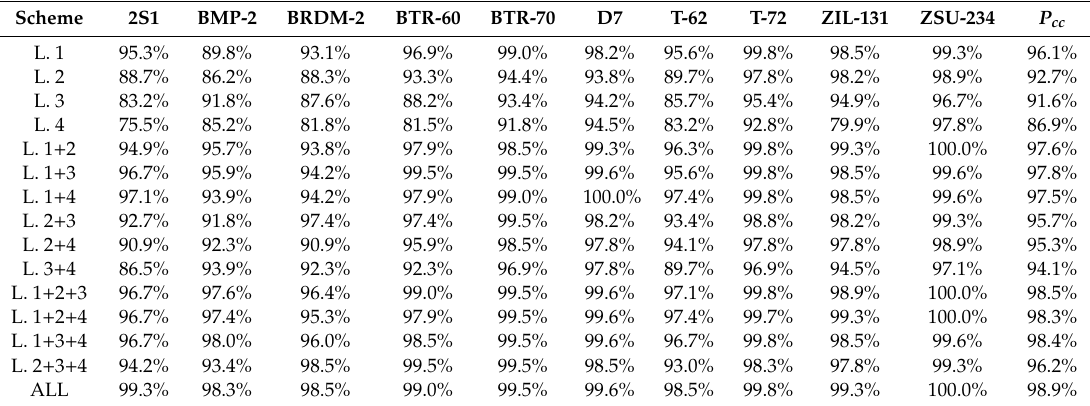
Table 6. Classification results of the ten-target MSTAR